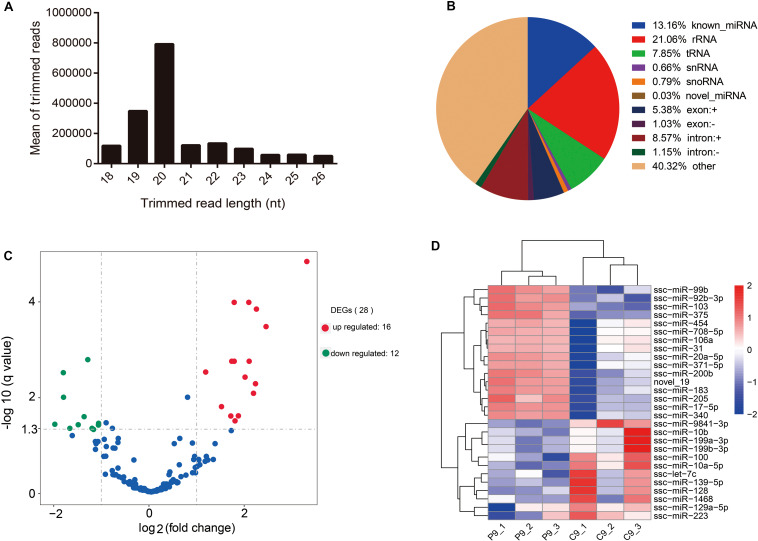
Overview of small RNA-Seq data. (A) Length distribution of read counts (after trimming) from Illumina sequencing of exosome samples (nt = nucleotides). (B) Relative abundance of different RNA species sequenced in porcine serum exosomes. (C) Volcano plots of differentially expressed miRNAs. X-axis denotes fold change (log2); Y-axis refers to the q value (−log10). (D) Hierarchical clustering of DE miRNAs.